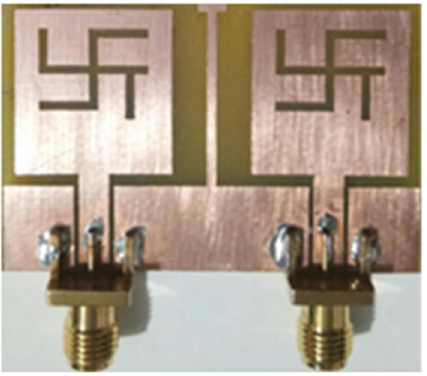
Figure 12. Measured S − parameters for dual-band MIMO antenna [47].